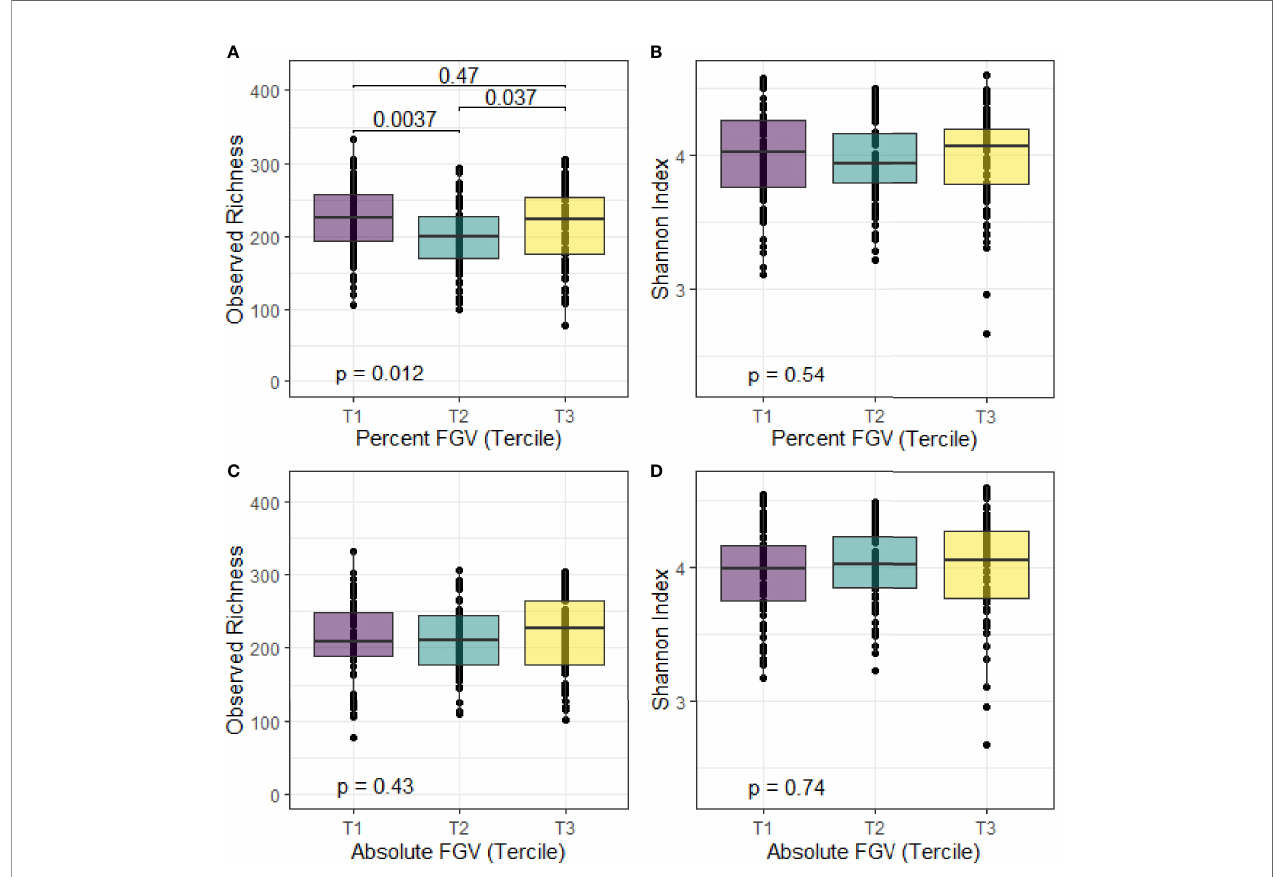
FIGURE 2 | Box plots of alpha diversity metrics for observed richness and Shannon index across terciles of %FGV (A, B) and aFGV (C, D) . P-values are presented for overall differences in alpha diversity metrics (Kruskal-Wallis) and post-hoc pairwise differences. Boxes represent the lower, median, and upper quartile of the data and whiskers are 1.5*interquartile range.